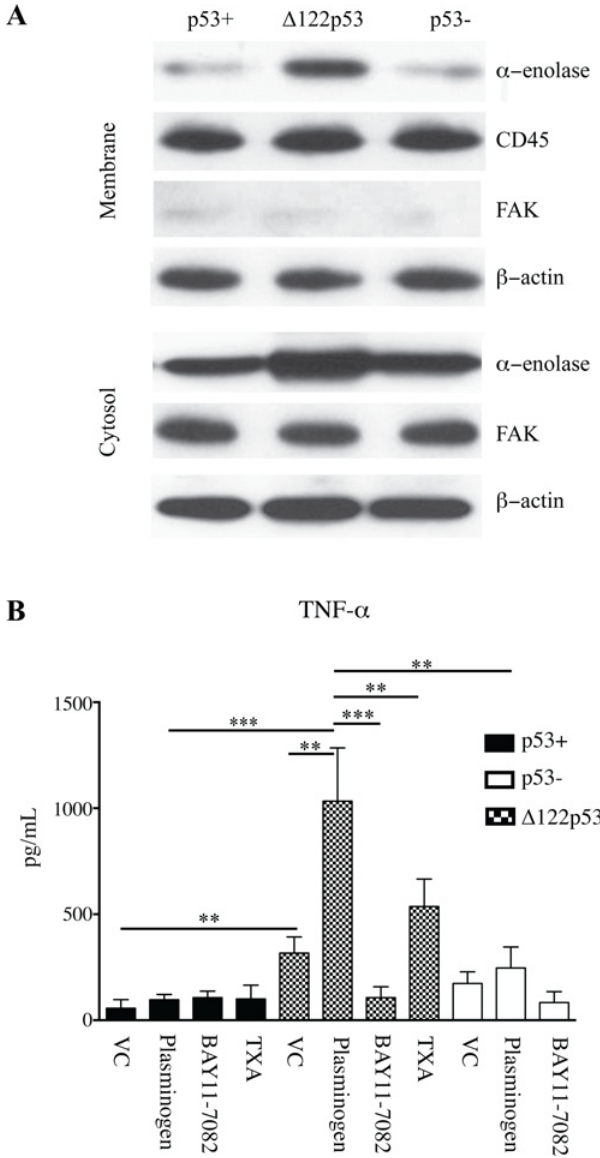
Figure 2. Increased alpha-enolase on the Δ 122p53 PBMC cell membrane. A . Increased alpha-enolase is present on the cell membrane of Δ 122p53 PBMCs compared to that on p53- and p53+ PBMCs. The cell membrane and cytosolic fractions of untreated PBMCs from p53+, p53-, and Δ 122p53 mice were separated and subjected to western blotting with an antibody to alpha-enolase. β -actin, FAK, and CD45 were used as loading controls for total protein, cytosolic, and cell membrane fractions, respectively. B . Increased TNF- alpha was released from Δ 122p53 PBMCs following plasminogen stimulation compared with that from p53+ and p53- PBMCs. PBMCs were pre-incubated with plasminogen (lys-plasminogen) with or without the NF κ B inhibitor BAY 11 – 7082 (2.5 μ M for 90 minutes), or the inhibitor to plasmin activation (TXA, 10 mM), or vehicle- treated only (VC). Following pre-incubation and prior to TNF-alpha measurement, tissue plasminogen activator (3 nM) was added, and the amount of TNF-alpha secreted in culture media was measured by ELISA. The results represent the mean ± SD (n = 3 for each measurement). *** , P < 0.001, ** , P < 0.01, P < 0.05.